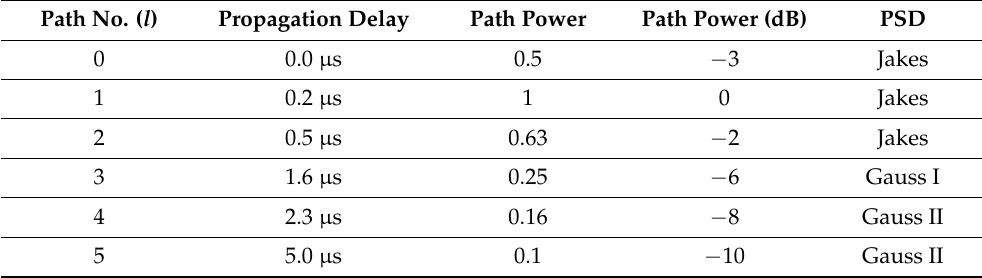
Table 4. The typical urban time-varying channel